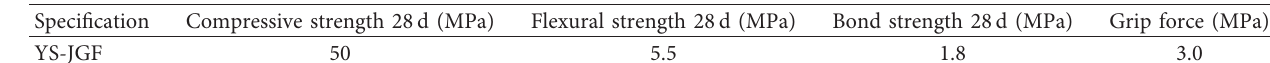
Table 2: Performance indexes of caulking